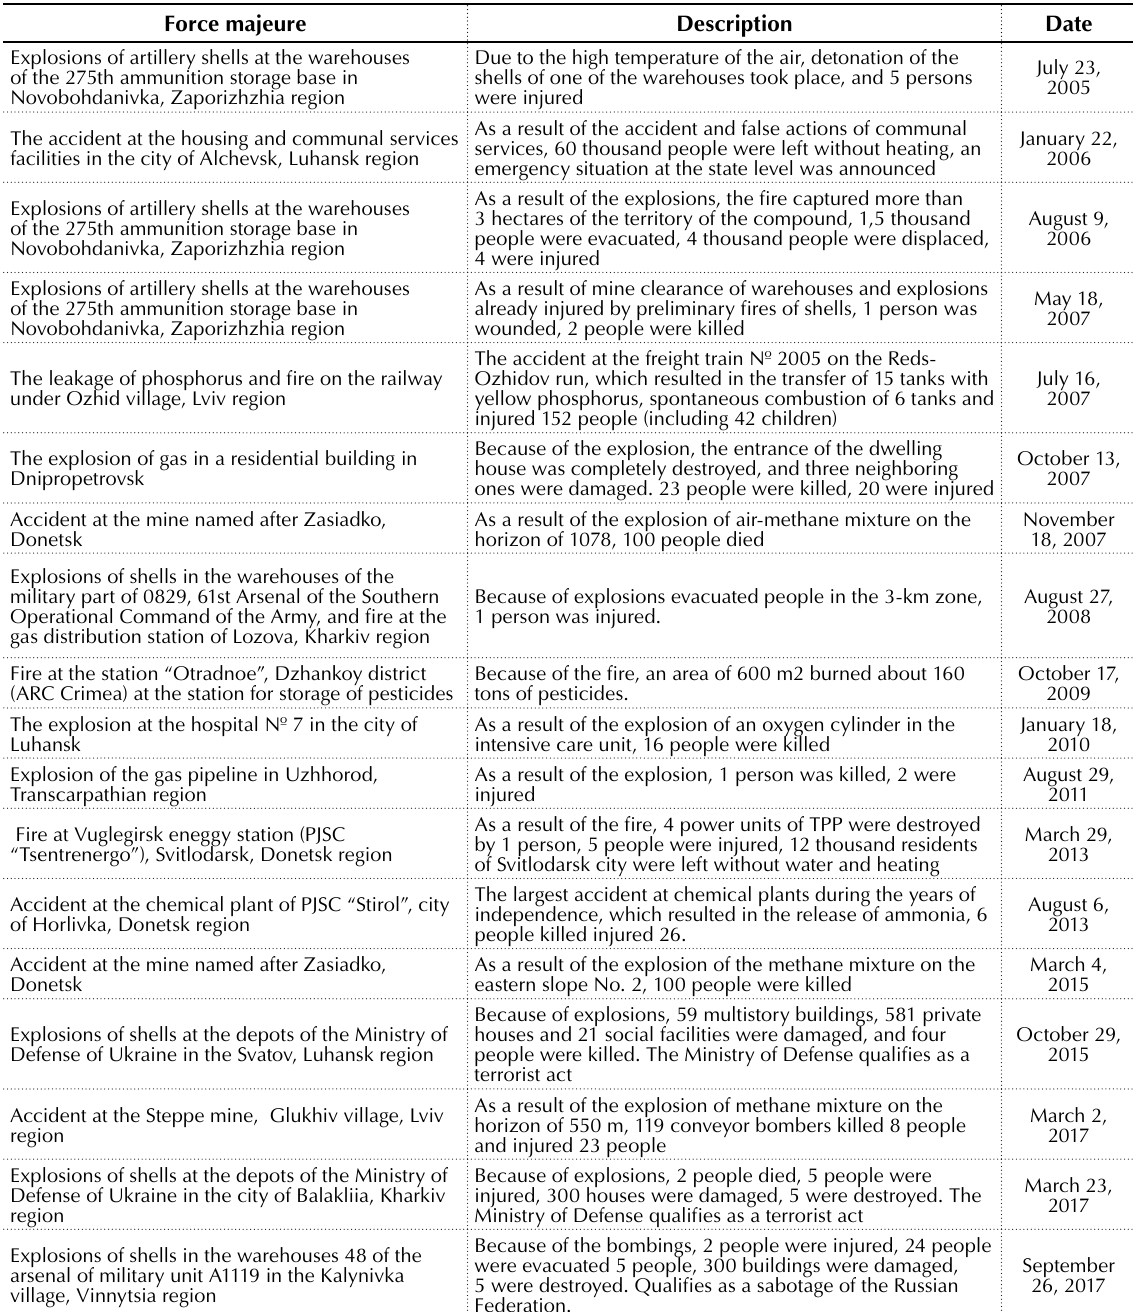
Table D1 (cont.). The main technological disasters in Ukraine during